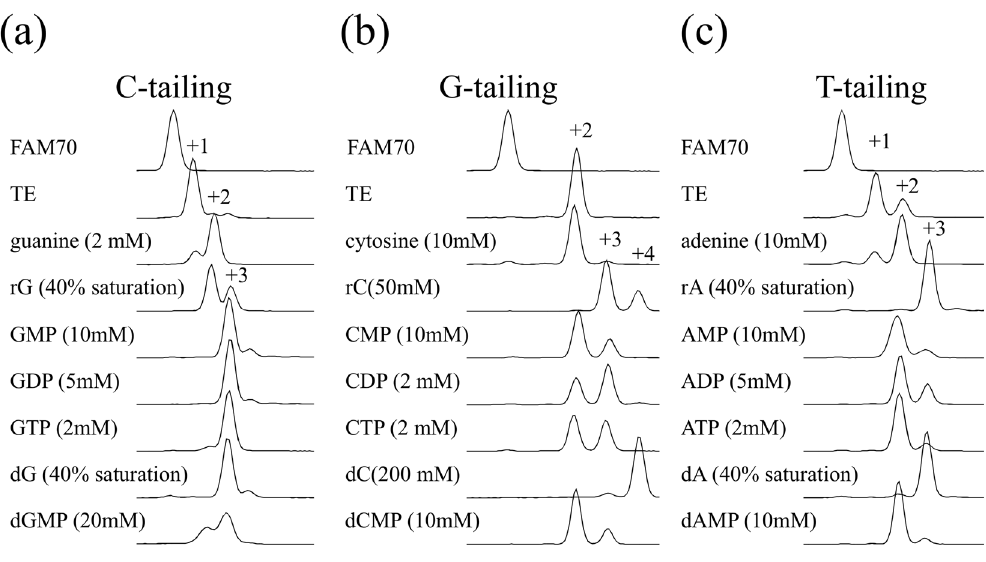
Figure 3. Effects of compounds at their optimum concentration on the tailing activity of MMLV-RT. ( a ) C-tailing, ( b ) G-tailing, and ( c ) T-tailing reactions were conducted in the presence of each compound at its optimal concentration. Some peaks are labeled with the size relative to unreacted